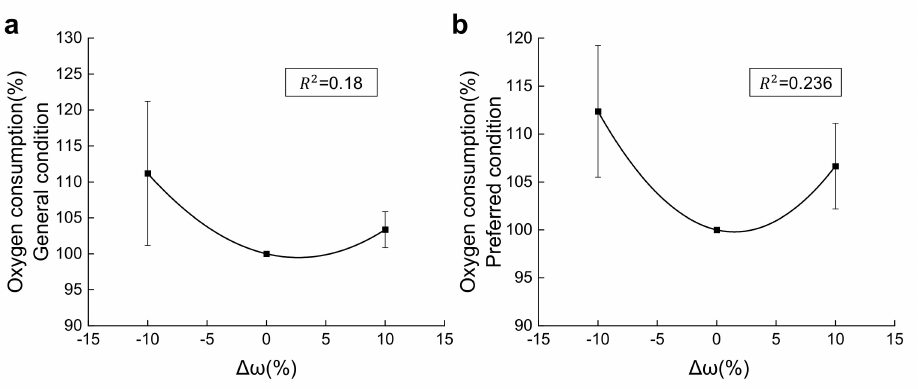
Figure 10. Mean and standard deviation of oxygen consumption (as a percentage of the value for walking at the preferred frequency) for the last two minutes of walking across the three different step frequency conditions. The step frequencies are plotted as the percentage difference from the preferred frequency, ∆ ω . The preferred step frequency is ∆ ω = 0%. The solid line represents the quadratic curve with error bars of standard deviation. Each subplot is a different condition: ( a ) general condition; ( b ) preferred